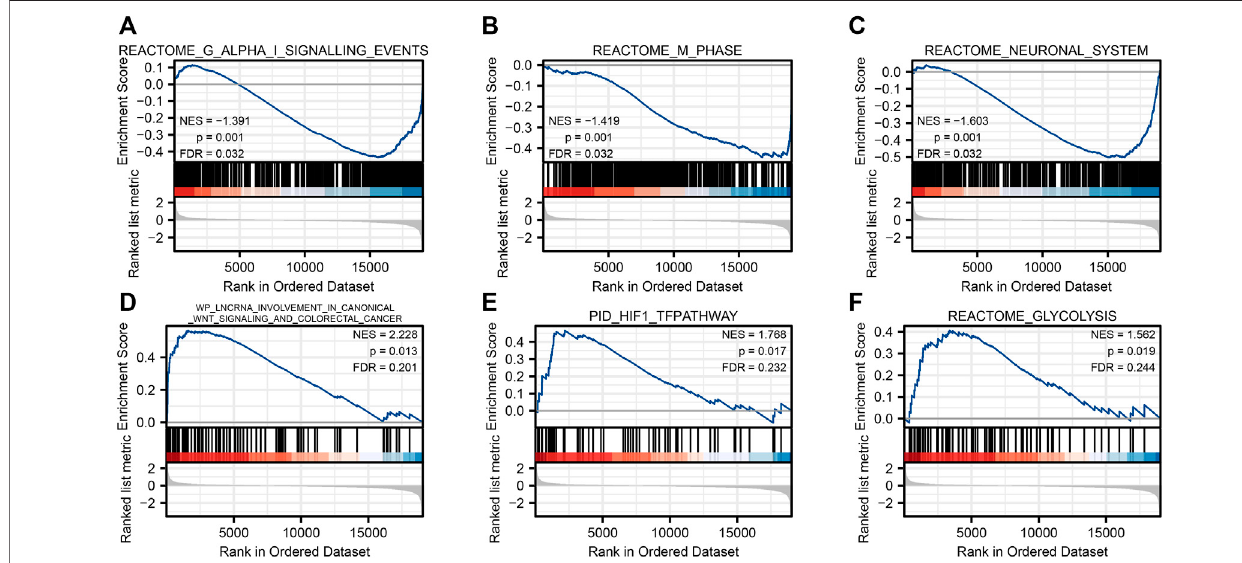
FIGURE5| Geneset enrichment analysis.Reactome Galpha Isignaling events (A) ,reactomemphase (B ),reactome neuronal system (C) ,WPlncrna involvement in canonical Wnt signaling and colorectal cancer (D) , PID HIF1 TFPATHWAY (E) , and reactome glycolysis (F) .